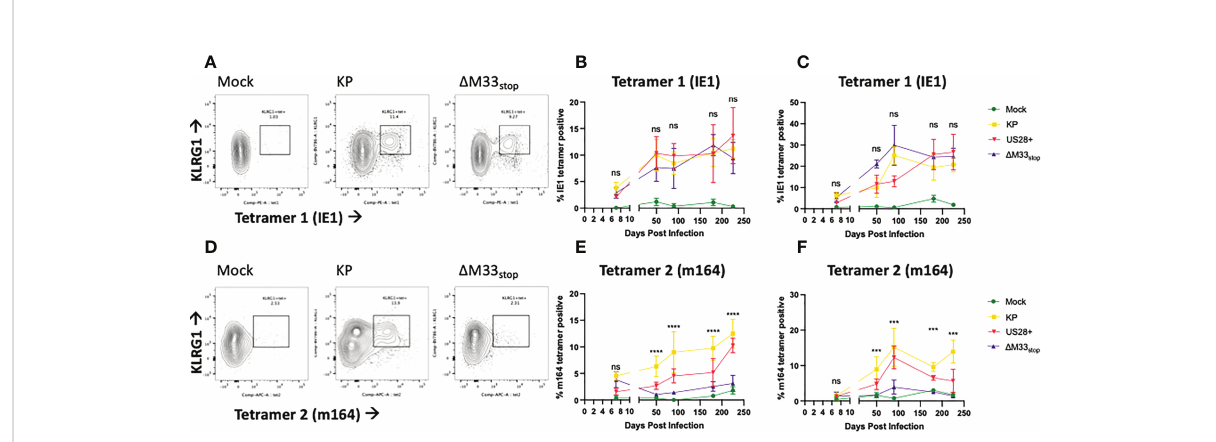
FIGURE 4 KP and D M33 stop induce differential epitope-speci fi c T cell memory in fl ation. BALB/c ByJ mice were infected with KP or D M33 stop or mock infected and sacri fi ced at time points from 7 dpi to 225 dpi. Flow cytometry was performed on lung- and spleen-derived lymphocytes, and gated on CD3 + CD8 + cells, representing CTLs. MHC tetramers loaded with peptides AGPPRYSRI (IE1) and YPHFMPTNL (m164) were used to label epitope-speci fi c T cells. Shown are percentages of KLRG1 + tet + T cells out of total CD8 + T cells. (A, D) Representative samples from 225 dpi are shown at left to demonstrate gating strategy. (B-C) IE1 tetramer-speci fi c T cells in the spleen (B) and lung (C) from mock (green), KP (yellow), US28 + (red) and D M33 stop (purple) infected mice. (E-F) m164 tetramer-speci fi c T cells in the spleen (E) and lung (F) . Minimum n=5 at each time point, except US28 + which is minimum n=3. ANOVA with pairwise comparison between KP and D M33 stop ; signi fi cance is shown as ***p<0.001; ****p<0.0001; ns, not signi fi